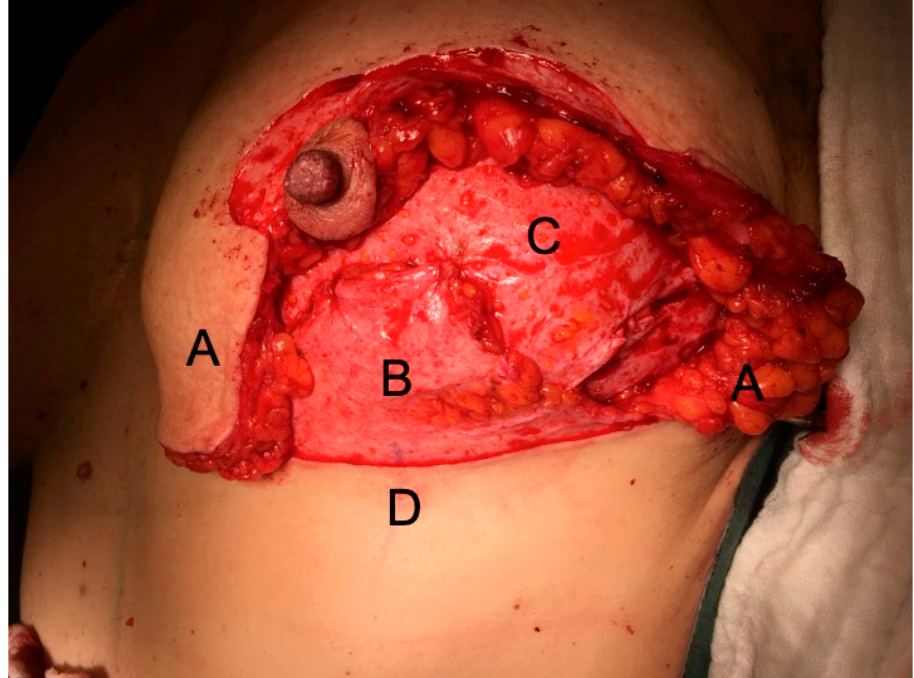
Figure 2. Intraoperative photograph of a DIEP flap inset after an NSM: ( A ), mastectomy skin flaps; ( B ), deepithelialized IBDF; ( C ), deepithelialized DIEP flap—the skin island to monitor flap perfusion can be positioned temporarily between the IBDF and the areola; ( D ), T-junction.